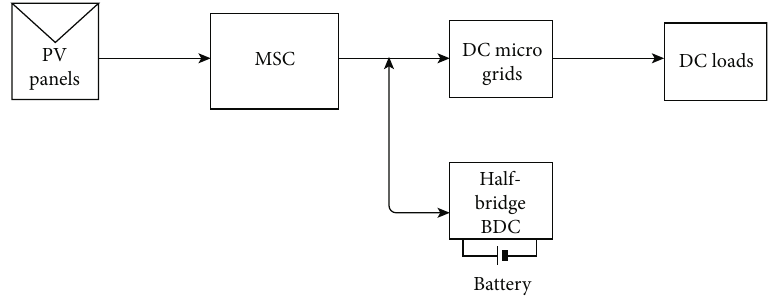
Figure 4: Proposed MSC integrated with PV system-based DC microgrid.